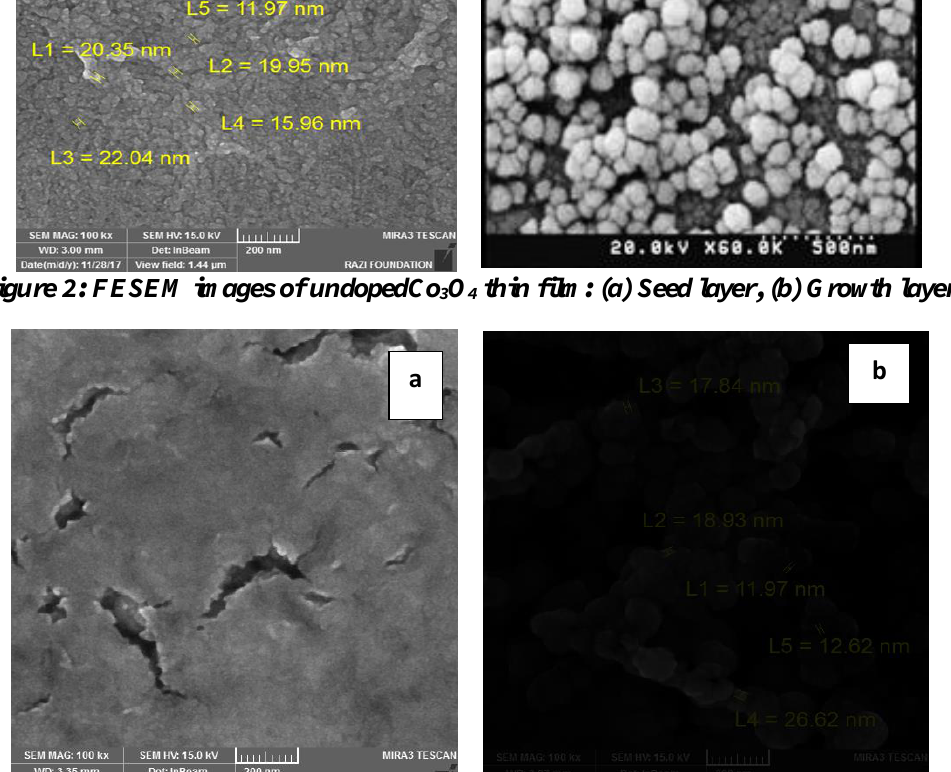
Figure 3: FESEM images of Co